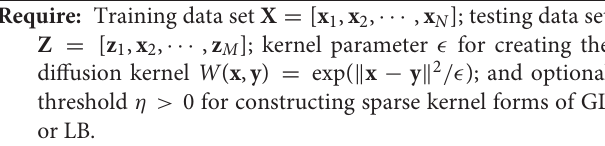
Algorithm 1: Out-of-Sample DR Extension for